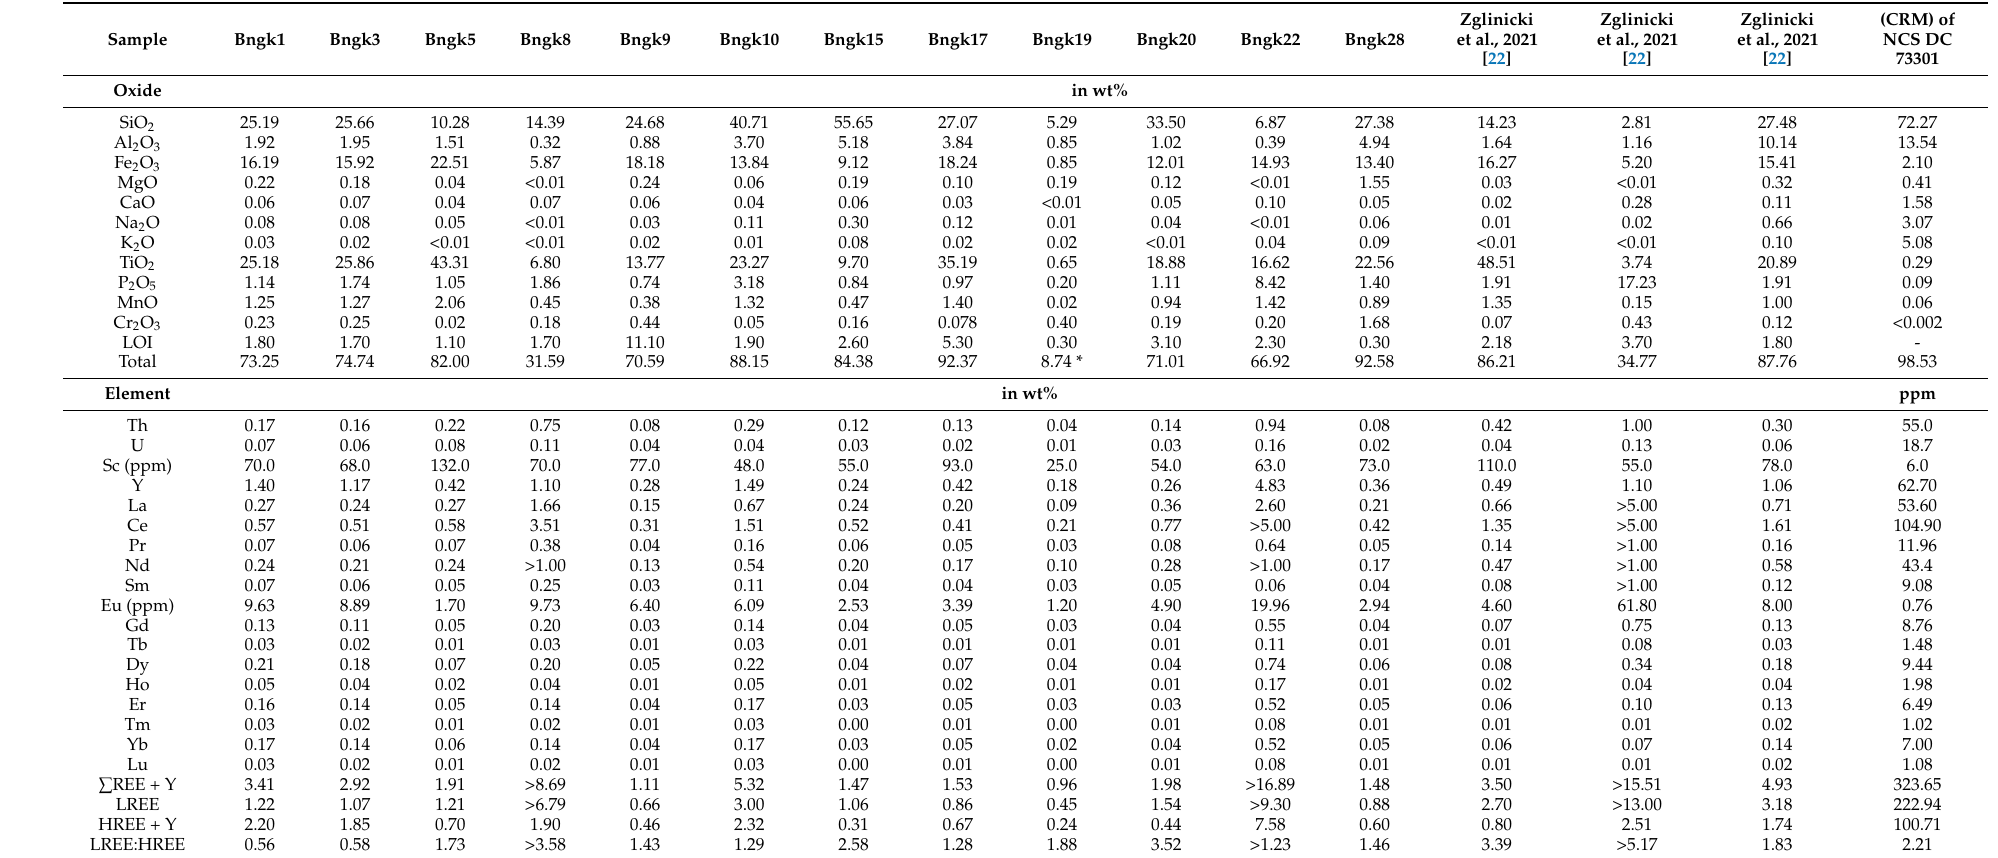
Table 6. Chemical compositions of tailings from Bangka Island. ICP-MS/ES